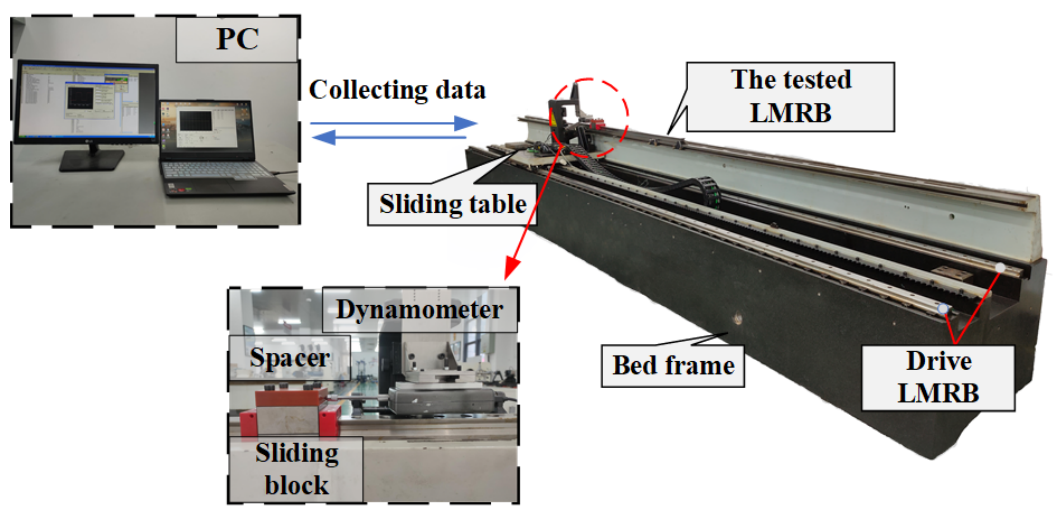
Figure 3. Preload drag force test bench.